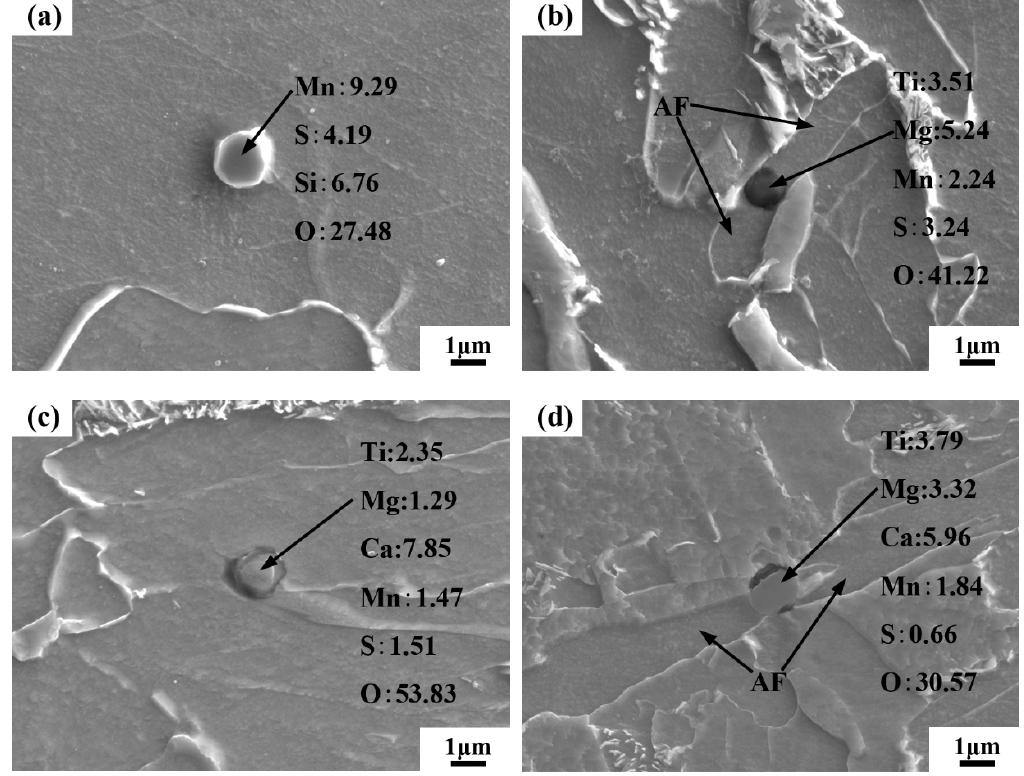
Figure 1. Evolution of typical inclusions about shape and composition.( a ) ladle furnace (LF)